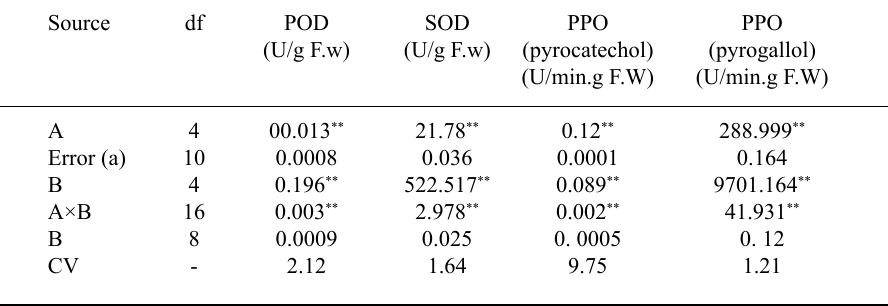
table 1. Analysis of variance (ANOVA) effects due to irradiation with five different doses (0, 1.5, 3.5, 5.5 and 7.5 kGy) on peroxidase (POD), super oxidase (SOD) and polyphenol oxidase